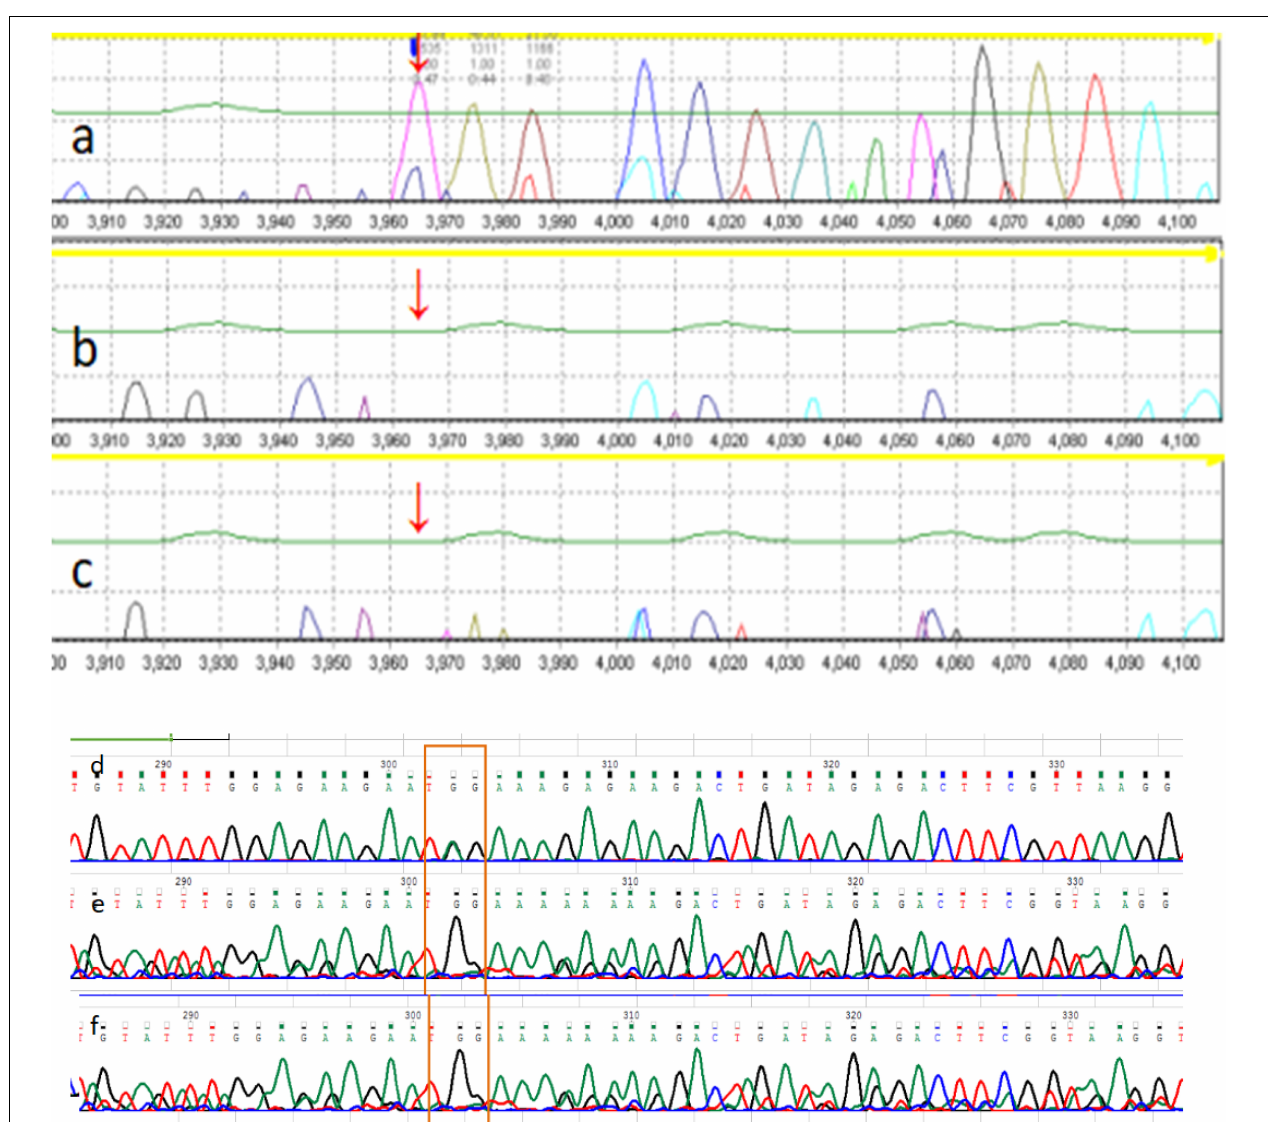
FIGURE 2 | The family pedigree of patient 1. The pedigree of the family with Coffin-Siris syndrome (CSS). (a) P1 ARID2 c.2610delT; (b) P1 father ARID2 gene c.2610T (wild type); (c) P1 mother ARID2 c.2610T (wild type). The mutation is de novo in the proband, whereas the parents are wild-type. The family pedigree of patient 2. The pedigree of the family with Coffin-Siris syndrome (CSS). (d) P2 father ARID2 c.674G (wild type); (e) P2 ARID2 c.674G > A; p. Trp225 *; (f) P2 mother ARID2 c.674G > A; p. Trp225